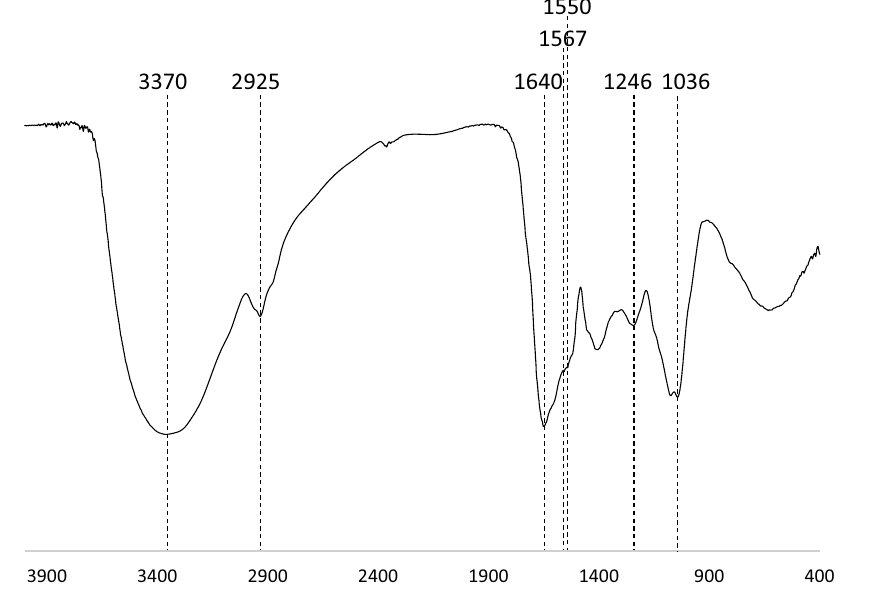
Figure 6. FT-IR spectrum of the > 3 kDa fraction of the corn silk water extract.